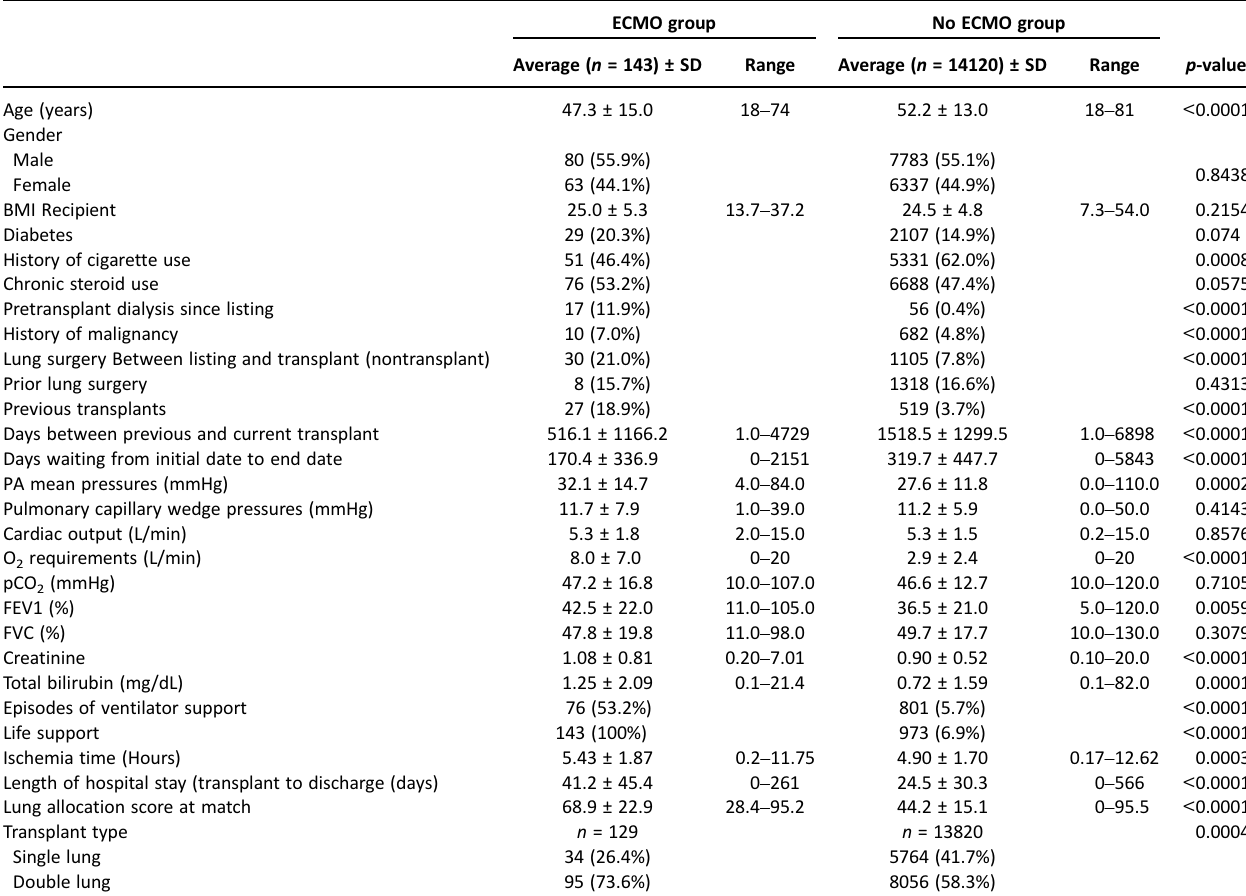
Table 2. Recipient